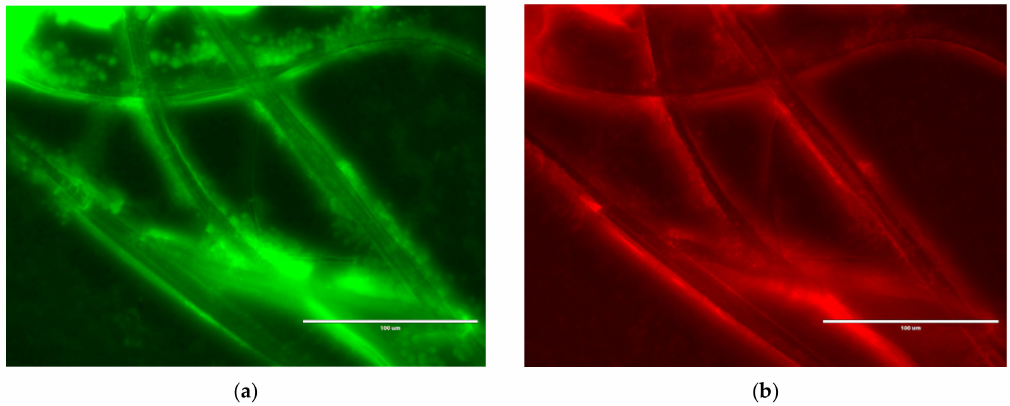
Figure 7. Antibacterial activity of nanocomposite fibres containing 8 wt % tungsten oxide against S. aureus after 24 h incubation. ( a ) Green, SYTO ® 9, corresponds to viable cells and ( b ) red, propidium iodide, corresponds to nonviable